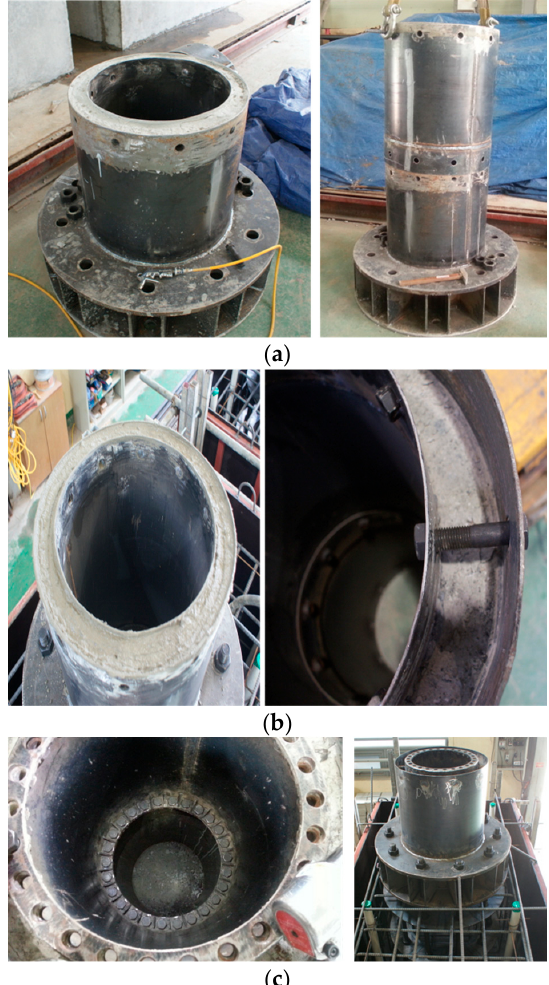
Figure 15. Three types of specimen modules ( a ) Type-S specimen module, ( b ) Type-H specimen module, ( c ) Type-W specimen module.